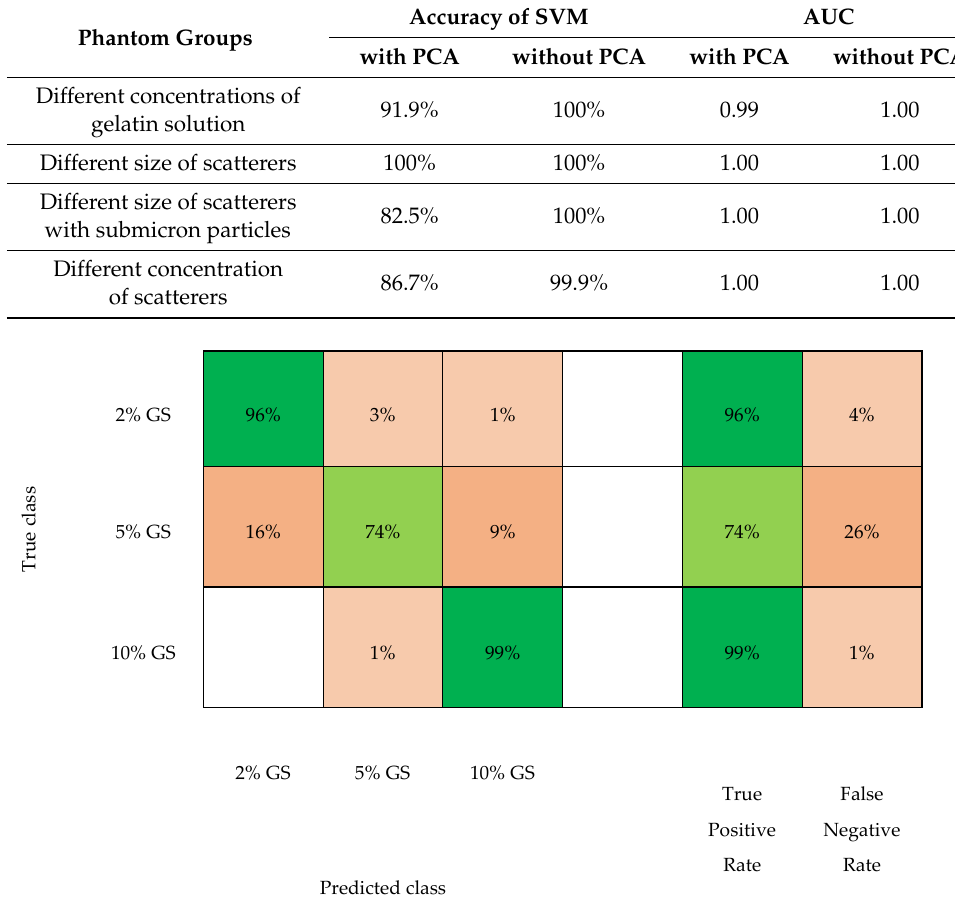
Figure 5. Confusion matrix of different concentrations of gelatin solution.